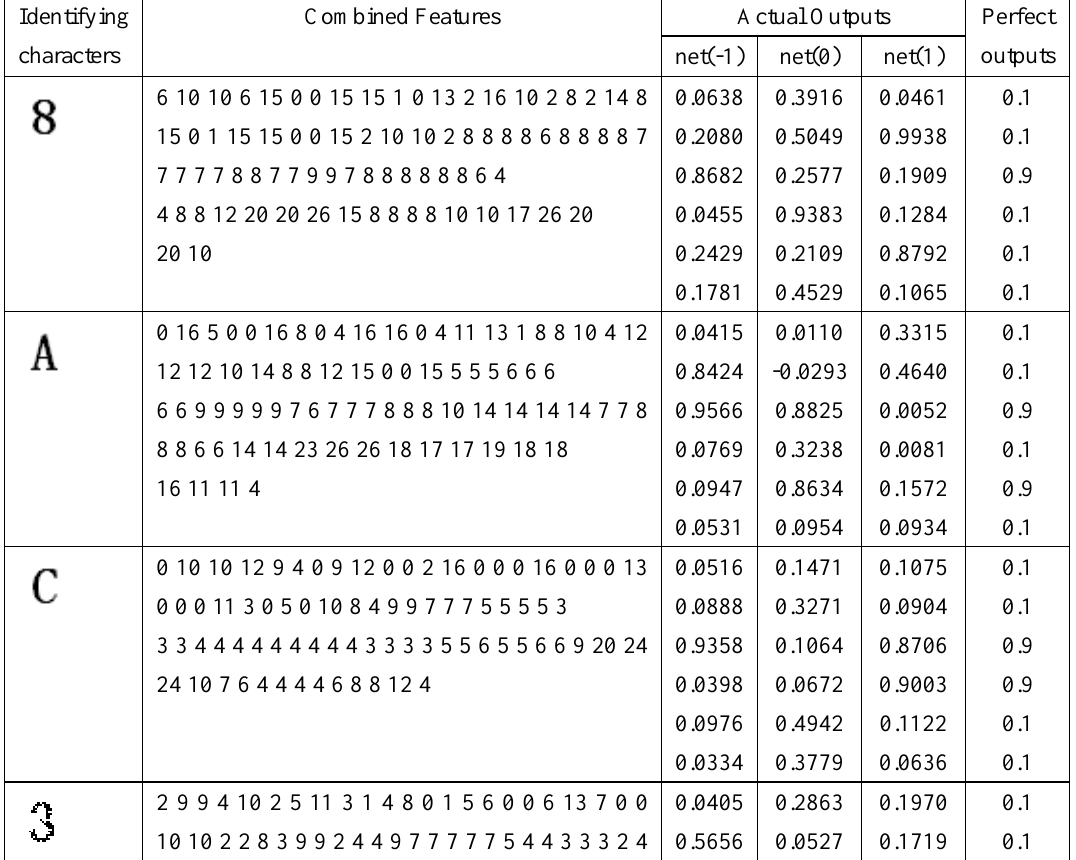
Table 4 The recognition results of partial